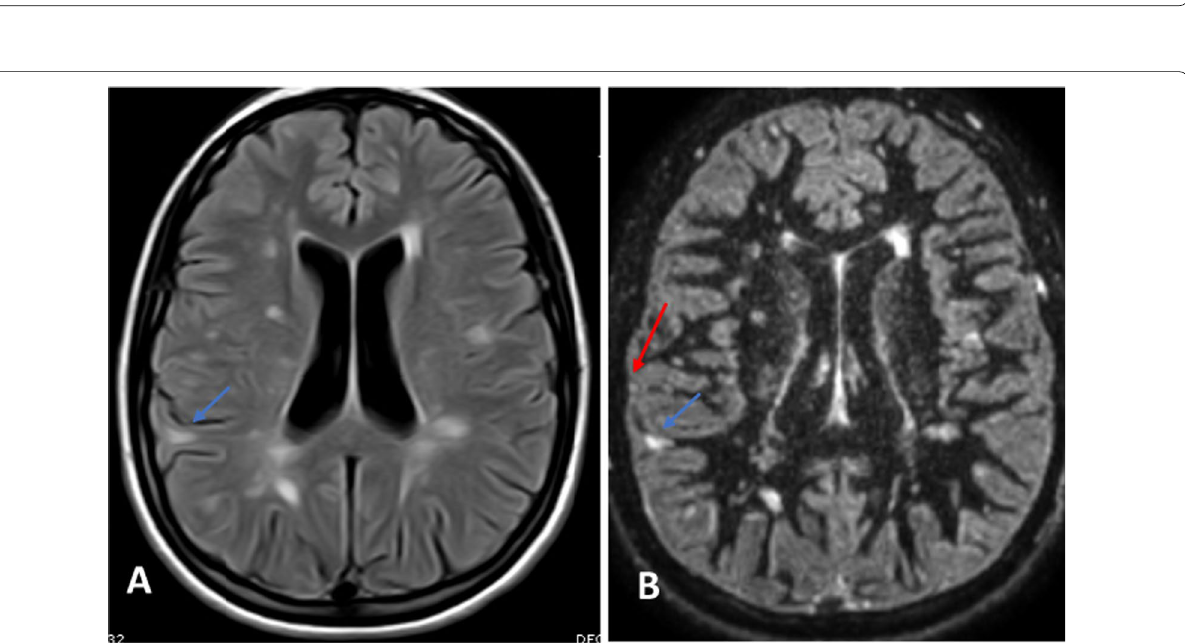
Fig. 2 A 35-year-old female patient with relapsing–remitting MS and EDSS score of 2.5. A Axial FLAIR revealed right parietal cortical/juxtacortical plaques (blue arrow) and multiple periventricular, deep white matter and cortical plaques. B Axial DIR at the same level clearly define the right parietal plaque as juxtacortical plaques, it also revealed type 3 cortical plaques (red arrow) which were seen only in the DIR, and multiple periventricular, deep white matter and cortical plaques are also